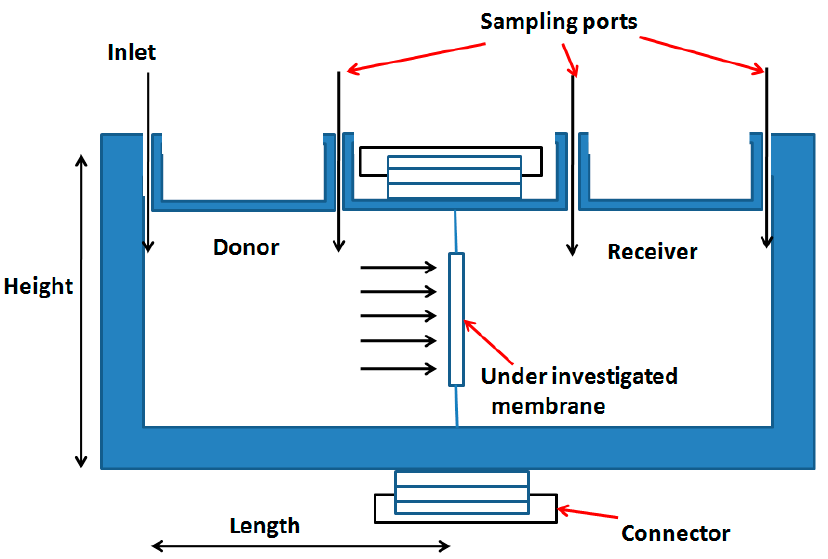
Figure 2. Schematic diagram of the diffusion cell used in the measurements of glucose diffusivity in commercial membranes and in-house electrospun scaffold materials.